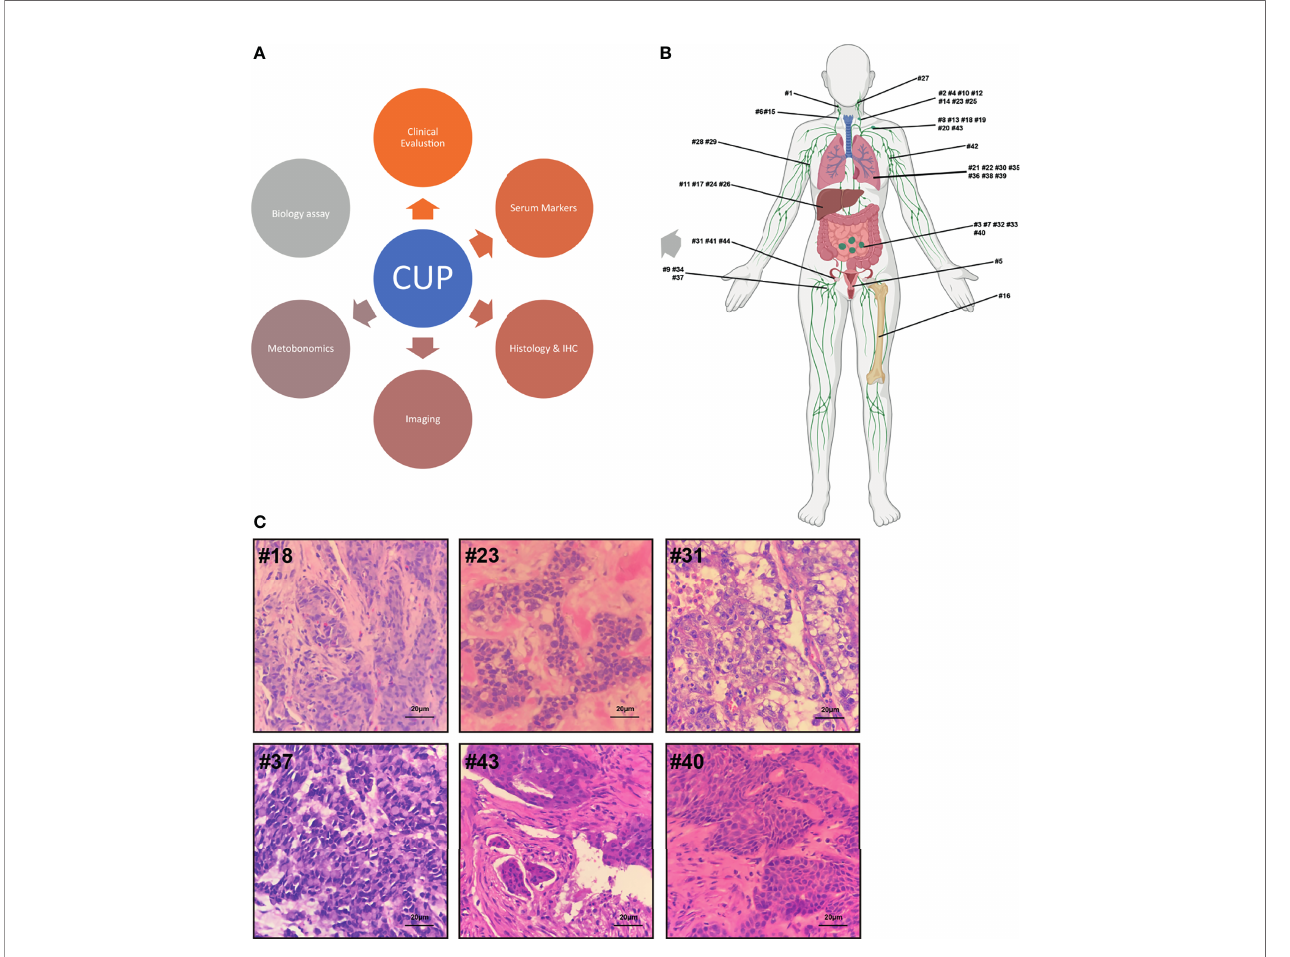
FIGURE 2 | (A) Multistep origin of CUP diagnostic work fl ow. (B) Metastases distribution: The 44 metastases were retrieved from surgery and puncture biopsy specimens from 44 CUP patients. (C) Histology: Most metastatic lesions are composed of poorly